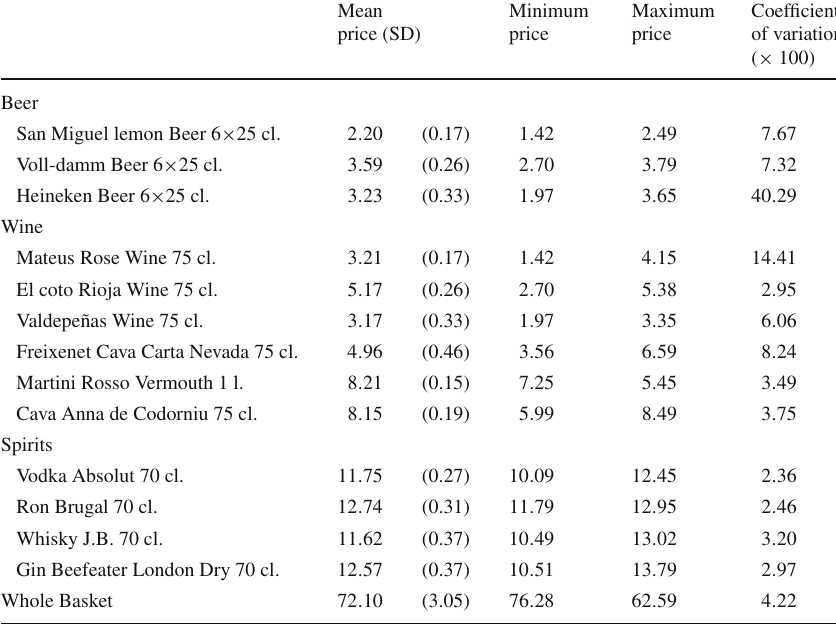
Table 10 Summary statistics for items in the occasional basket